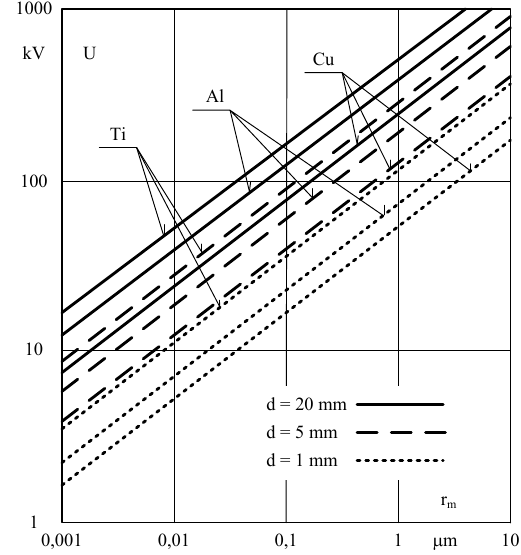
Fig. 1. The dependence of the minimum voltage value that causes the spherical microparticle to accelerate to the velocity causing the plastic deformation of the electrode surface in which it strikes from the radius of the microparticle; the inter- electrode spacing d was 1, 5 and 20 mm, and the electrodes and striking microparticles were made of Cu, Al or Ti.